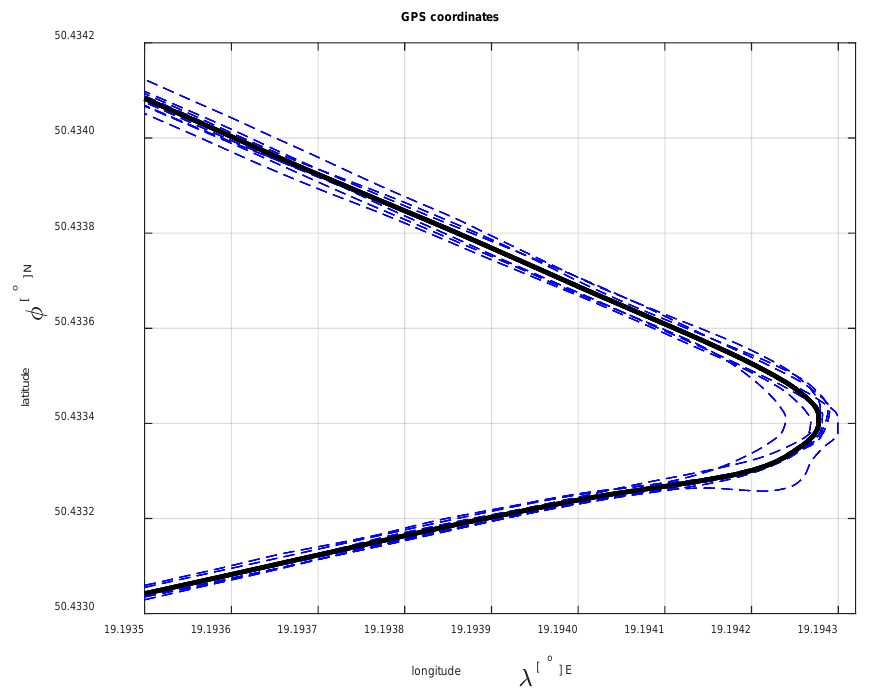
Figure 12. Averaged trajectory from eight trials.